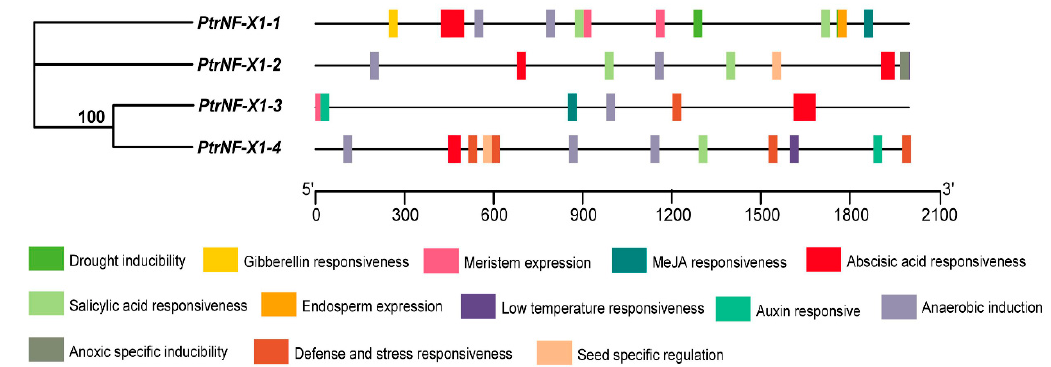
Figure 5. Cis-elements analysis of PtrNF-X1 . The relative locations of stress and growth related cis-elements in PtrNF-X1 promoter region. Different colors represent different cis-acting elements, and their position corresponds to the corresponding position of the promoter.